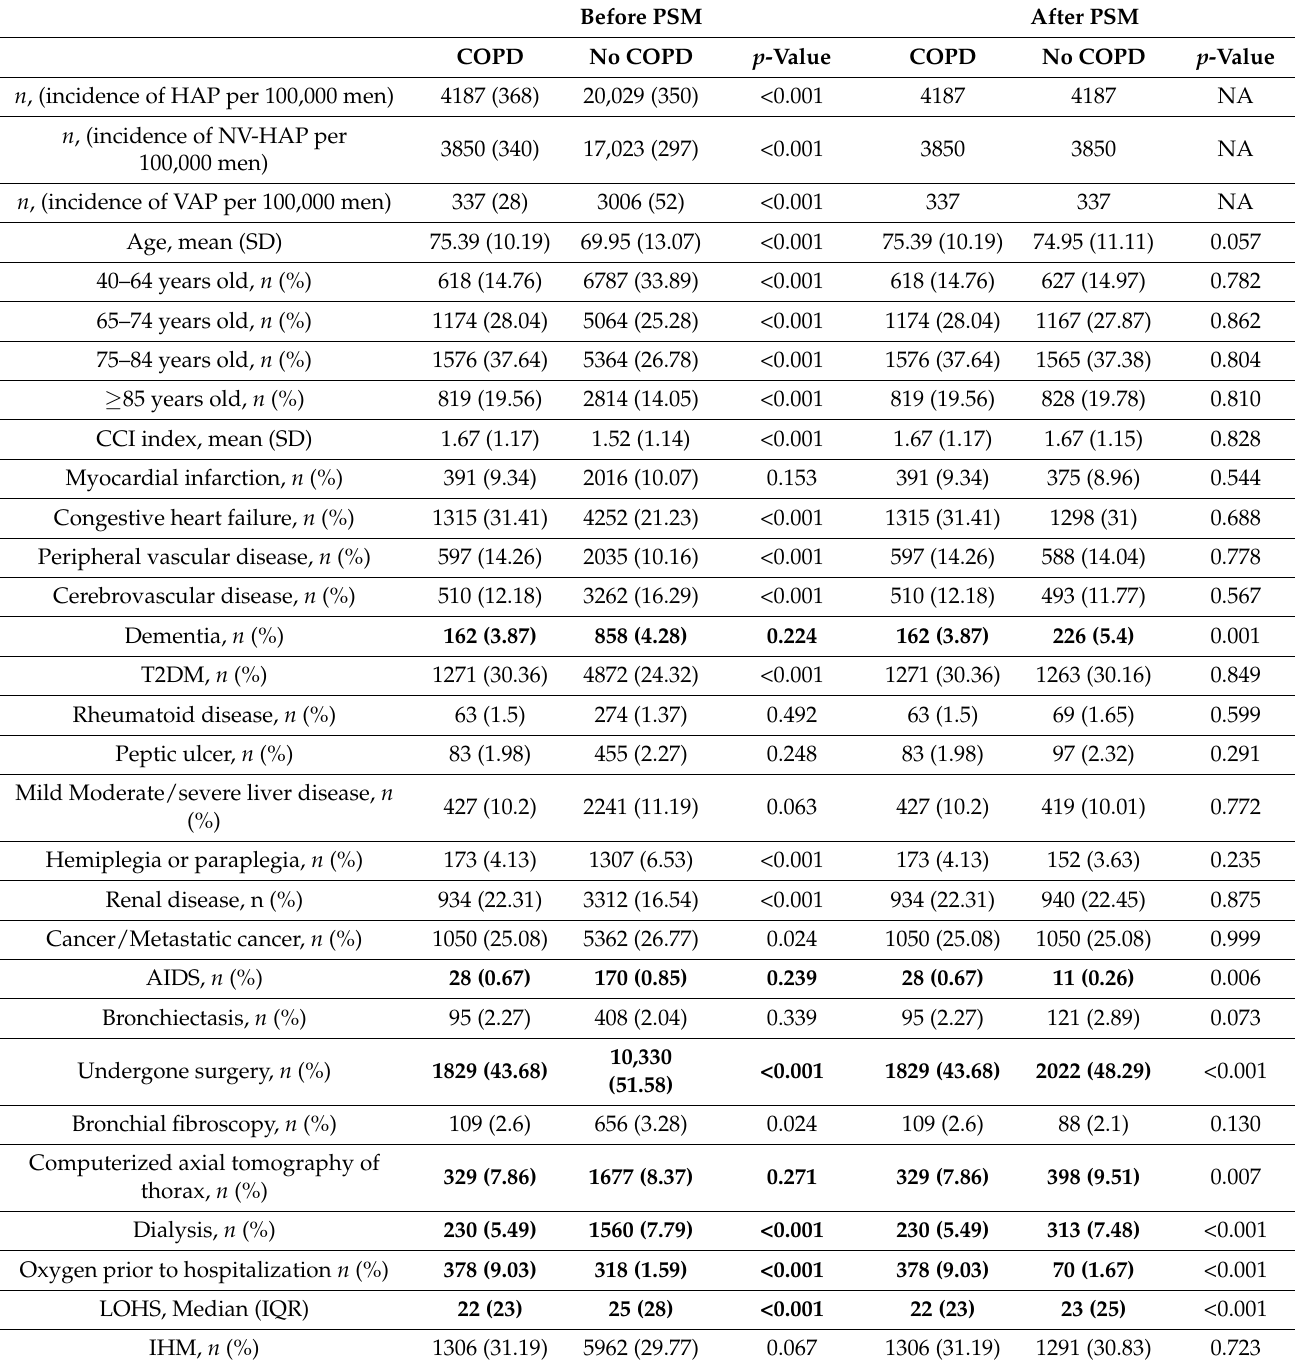
Table 3. Distribution of study covariates and hospital outcomes of MEN with and without COPD hospitalized with hospital-acquired pneumonia (HAP) in Spain (2016–2019), before and after propensity score matching (PSM). Before PSM After PSM COPD No COPD p -Value COPD No COPD p